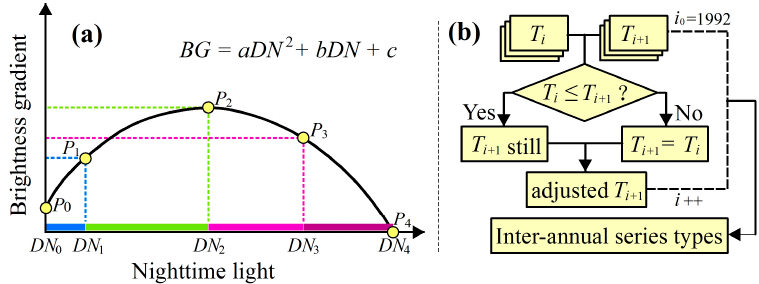
Figure 3. Schematic diagram of the ( a ) sub-region partitioning based on the quadratic polynomial; and ( b ) inter-annual series types generation. Table 1. Calculations for the split points drawn in Figure 3a based on the quadratic polynomial.